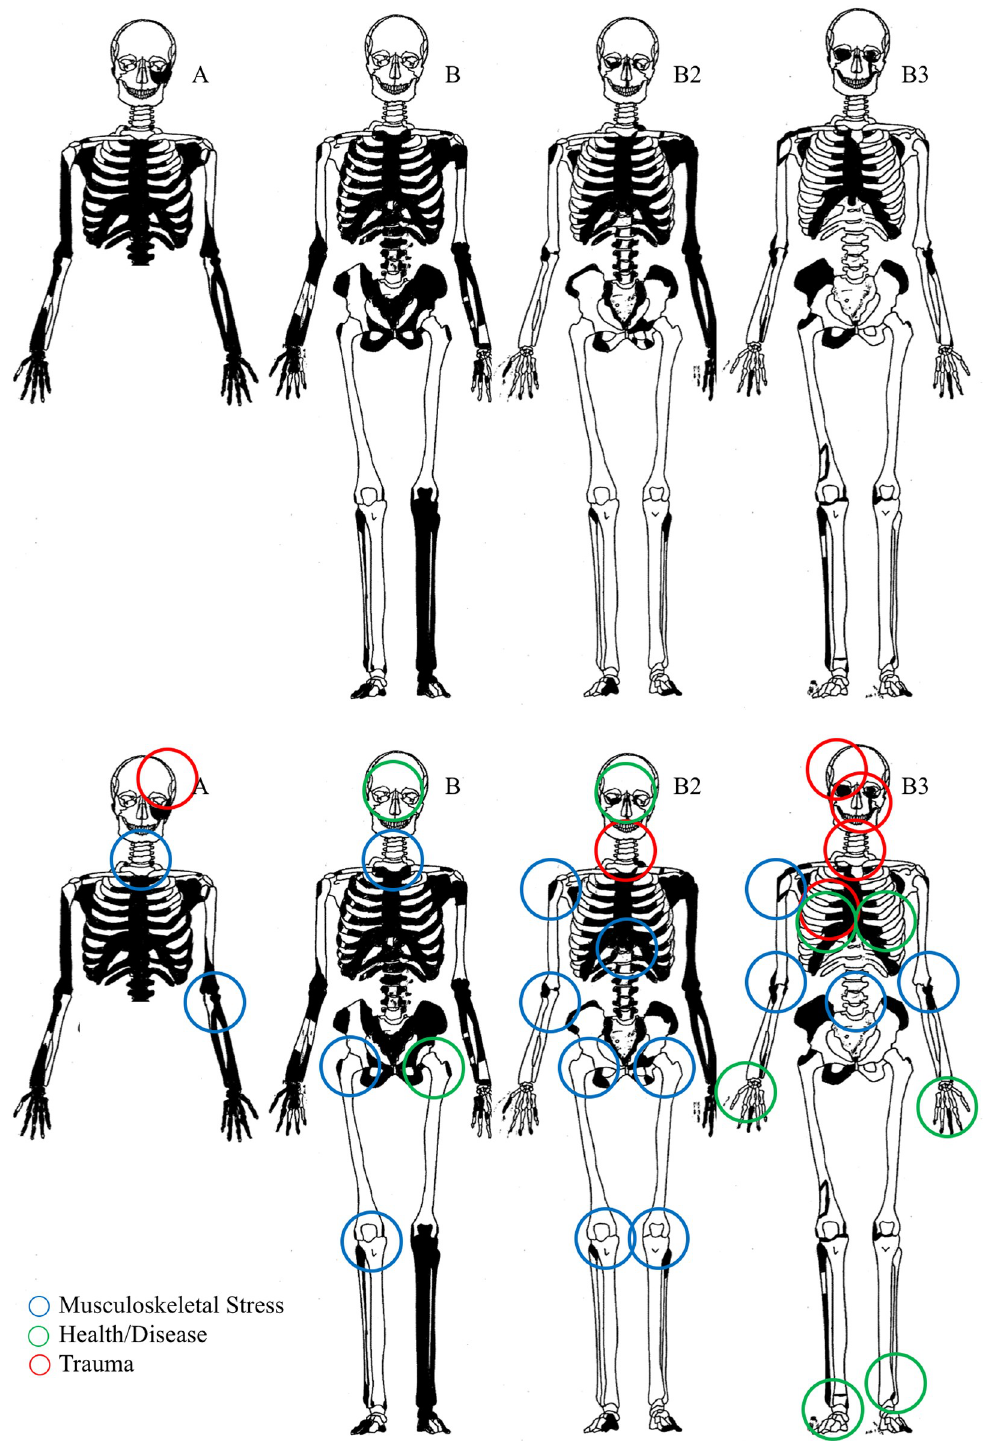
Fig 6. YNH4 element representation (top) and pathology distribution (bottom). Black = missing. Circles represent location and etiology of pathologies. Note YNH4 A is missing lower body elements. See text for details.